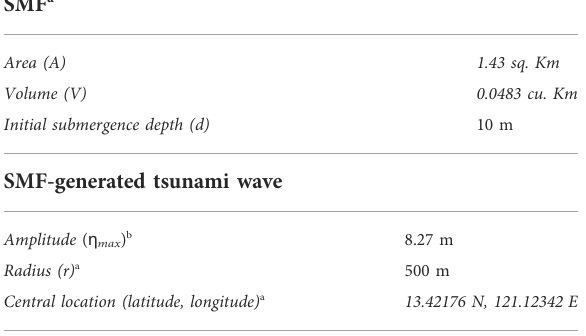
TABLE 6 SMF parameters used in this